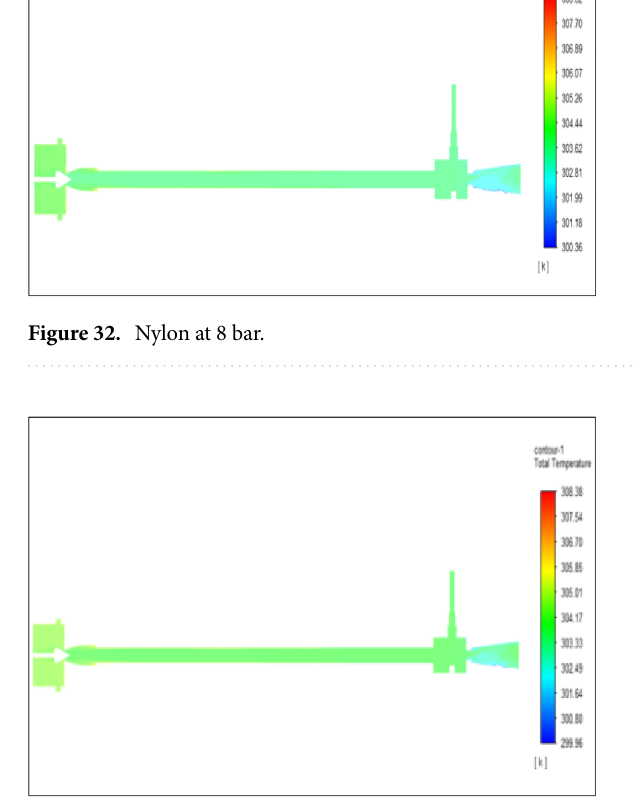
Figure 33. Bronze at 8 bar.